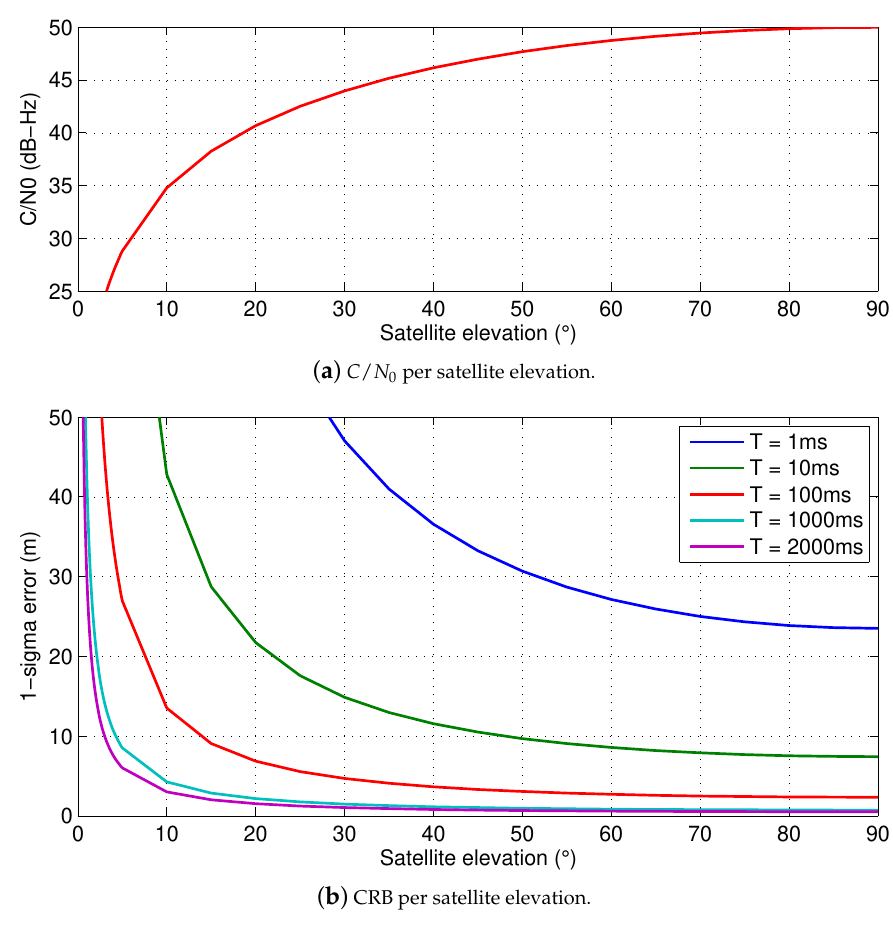
Figure 5. C / N 0 and standard deviation of the GNSS observables as a function of the satellite elevation, by considering a GPS L1 C/A signal sampled at F s = 4